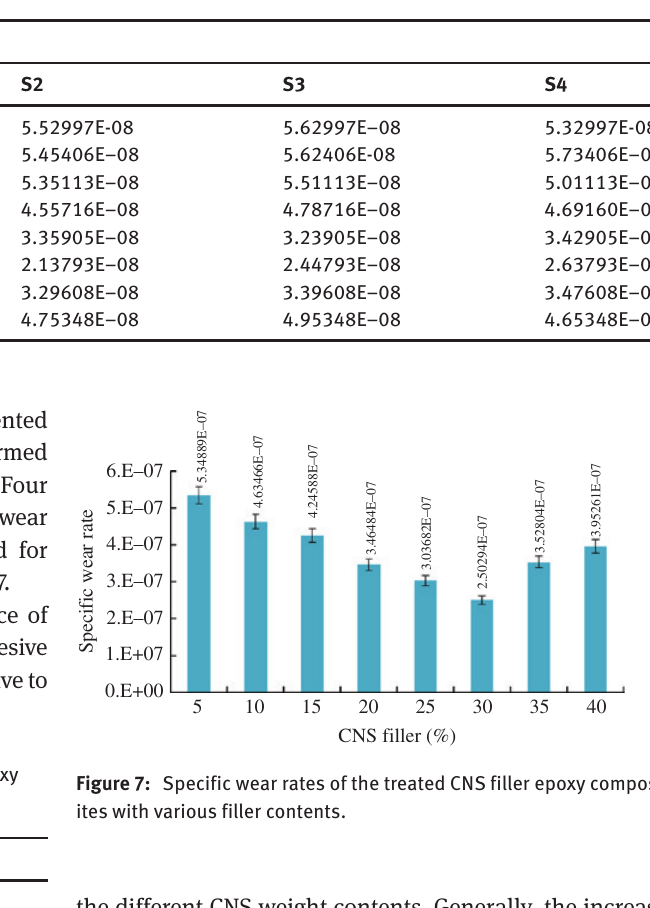
Table 1: Specific wear rates of the raw CNS filler epoxy composites with various filler contents.